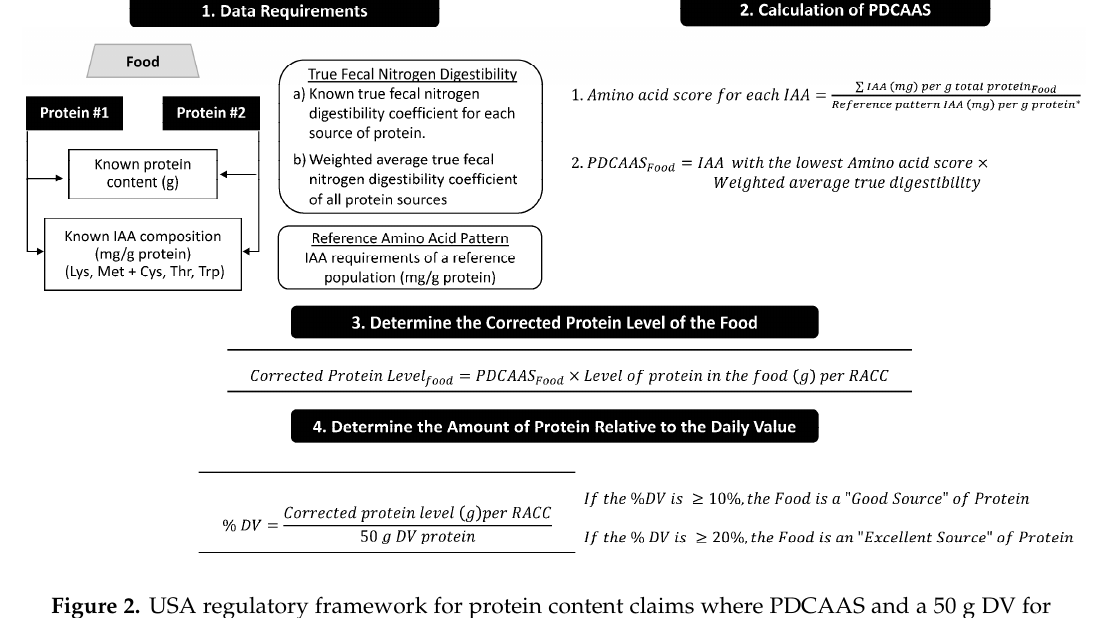
Figure 2. USA regulatory framework for protein content claims where PDCAAS and a 50 g DV for protein are used to determine if a food qualifies for a protein content claim [19]. This method applies to foods marketed to children ≥ 4 years through to adults. Only IAAs that are low particularly in plant-based foods are listed. DV, Daily Value; IAA, indispensable amino acid; Lys, lysine; Met + Cys, methionine + cysteine; PDCAAS, protein digestibility corrected amino acid score; RACC, reference amount customarily consumed; Thr, threonine; Trp, tryptophan. Figure 2 was adapted from Marinangeli and House [15].